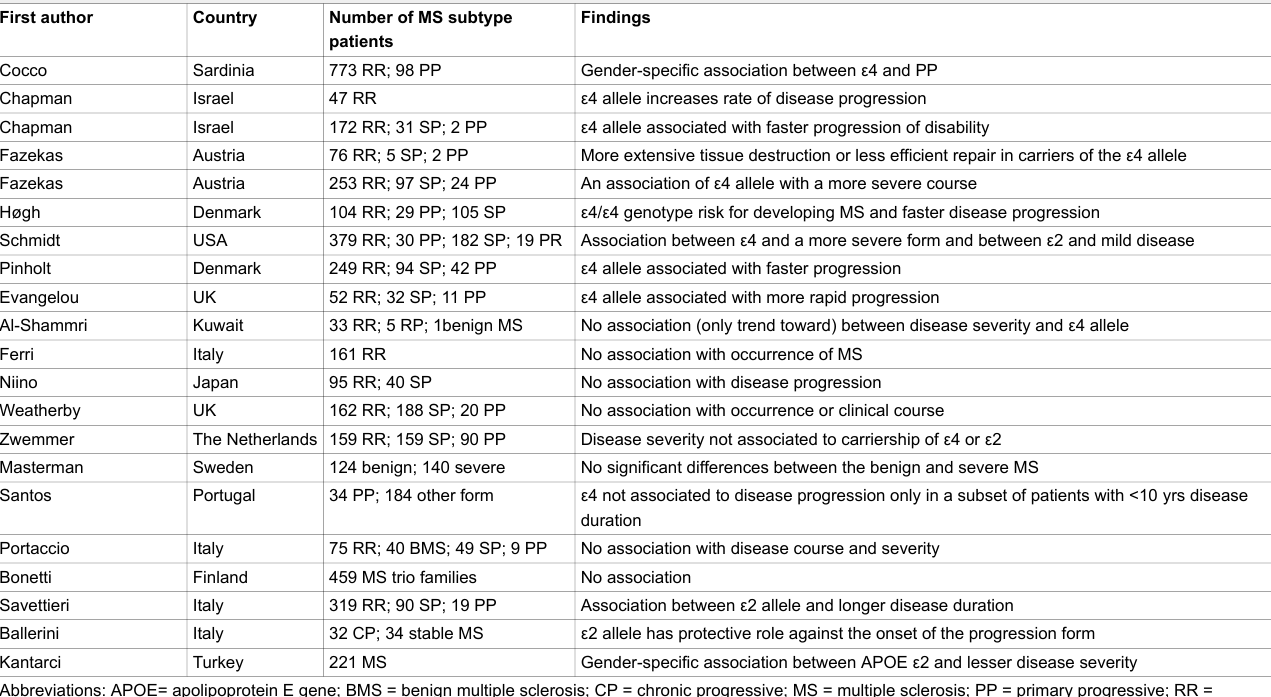
Table 1: Summary of studies investigating the association between APOE and